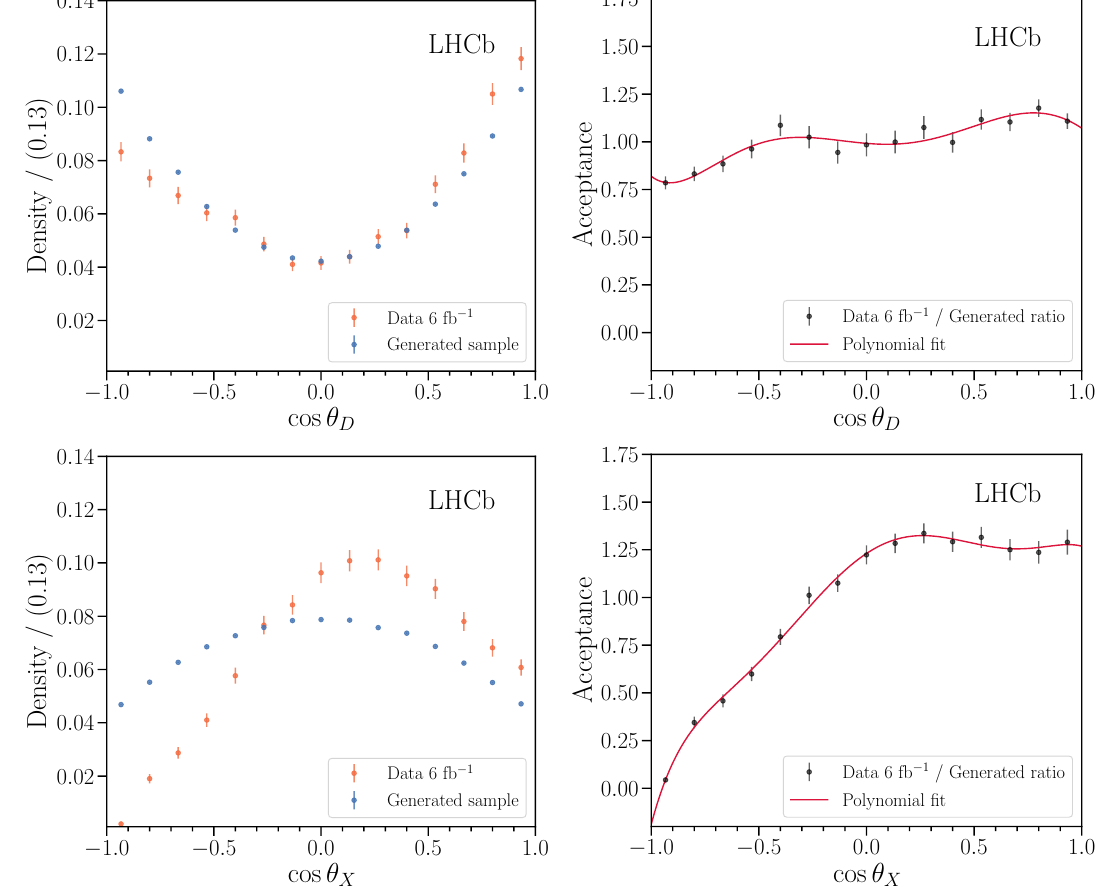
Figure 4 . (Left) Comparison of signal-weighted data and generated (top) cos θ D and (bottom) cos θ distributions, where the differences observed are due to the experimental acceptance and X resolution. (Right) Data to generated sample ratios, with the polynomial fits